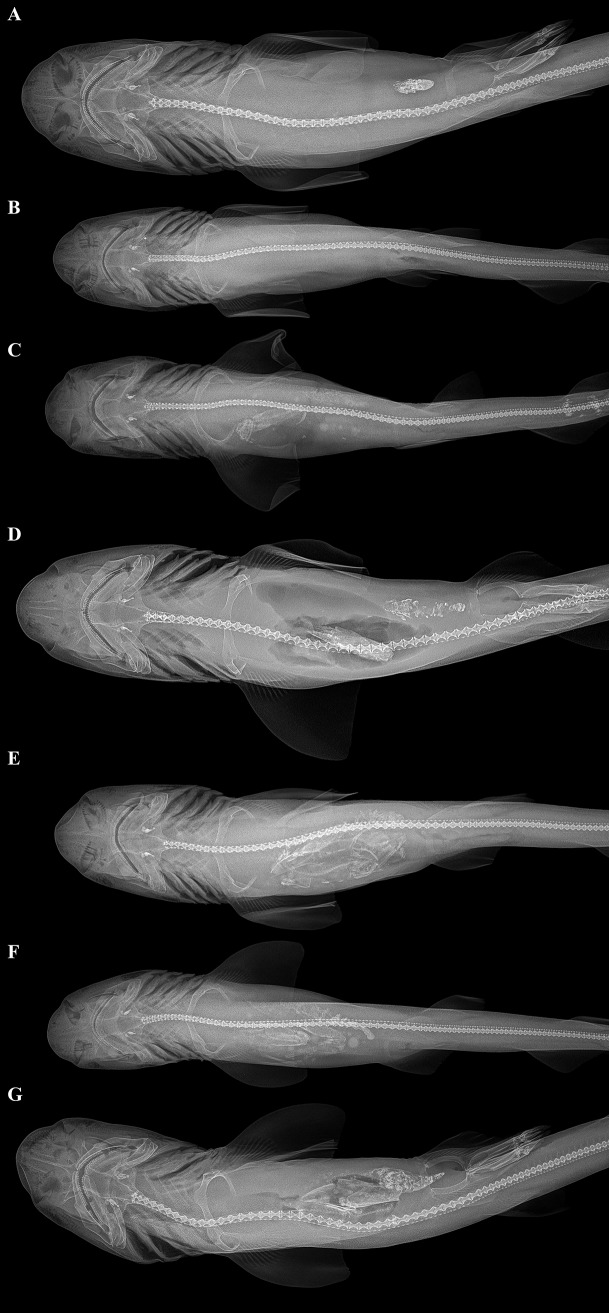
Exemplary radiographs of selected paratypes of Bythaelurus stewarti n. sp. in dorsal views depicting different scores of stomach fullness.(A) paratype, ZMH 26254, adult male, 391 mm TL, score 0, (B) paratype, ZMH 26254, juvenile female, 296.4 mm TL, score 0, (C) paratype, ZMH 26252, juvenile female, 299 mm TL, score 1 containing a teleost and few eye lenses, (D) paratype, ZMH 26254, adult male, 417 mm TL, score 1 containing a decapod (probably brachyuran) claw, (E) paratype, ZMH 26252, juvenile male, 340 mm TL, score 2 containing, among other remains, two decapod (probably brachyuran) claws and one teleost, (F) paratype, ZMH 26252, juvenile female, 299 mm TL, score 2 containing two decapod (probably brachyuran) claws and few eye lenses, and (G) paratype, ZMH 26254, adult male, 375 mm TL, score 2 containing a decapod (probably brachyuran) claw and a teleost.